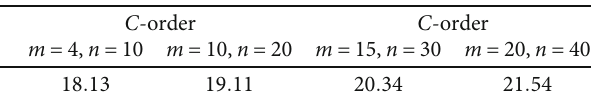
Table 6: C -order of the presented method for Example 9. C